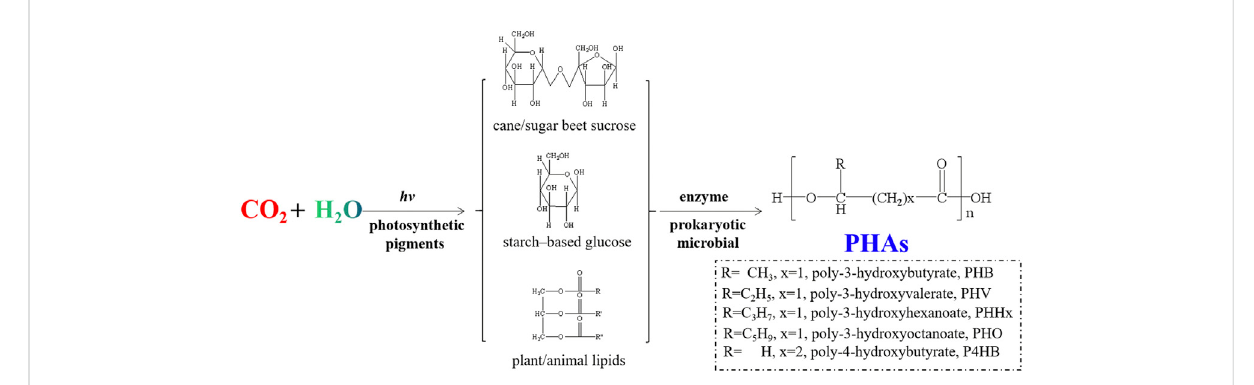
FIGURE 6 Schematic illustration for synthetic route of PHAs with different monomeric building